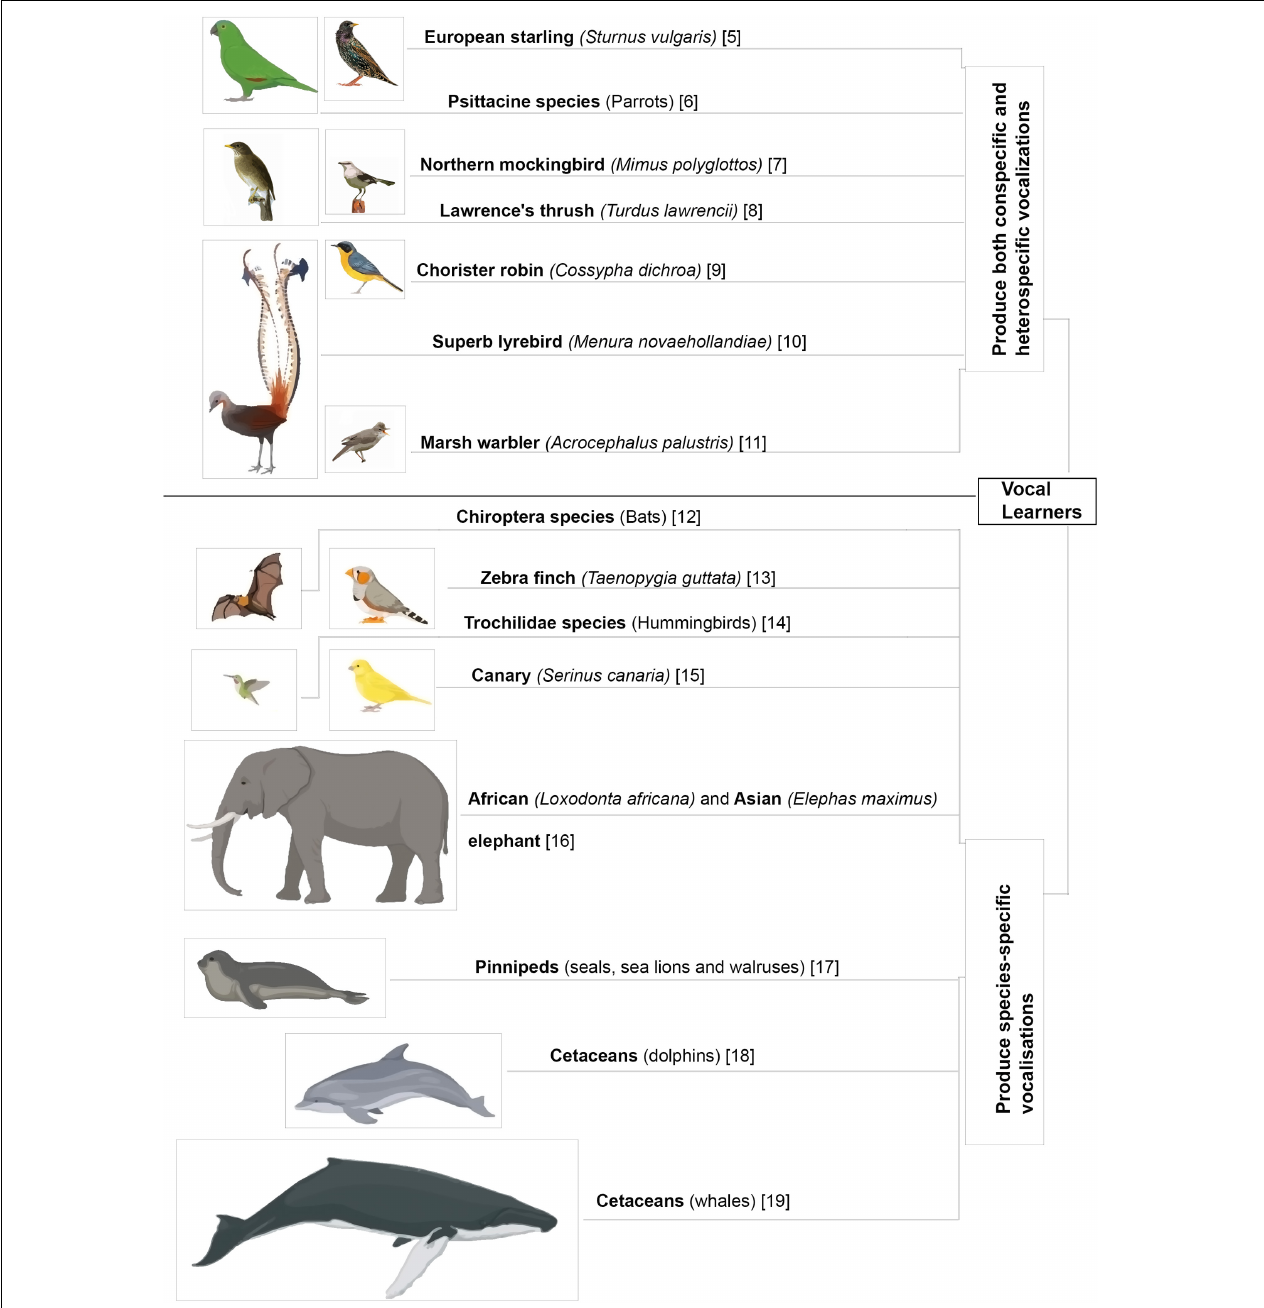
FIGURE 1 | Different animal species that learn to vocalize. Vocal mimics further enhance their vocal repertoires by including heterospecific and environmental sounds in their vocalizations (Harcus, 1977; Eens, 1997; Hardy and Parker, 1997; Dowsett-Lemaire, 2008; Gammon and Altizer, 2011; Balsby et al., 2012; Janik, 2014; Mello, 2014; Reichmuth and Casey, 2014; Stoeger and Manger, 2014; Favaro et al., 2016; Mori et al., 2018; Johnson and Clark, 2020; Vernes and Wilkinson, 2020; Dalziell et al., 2021).